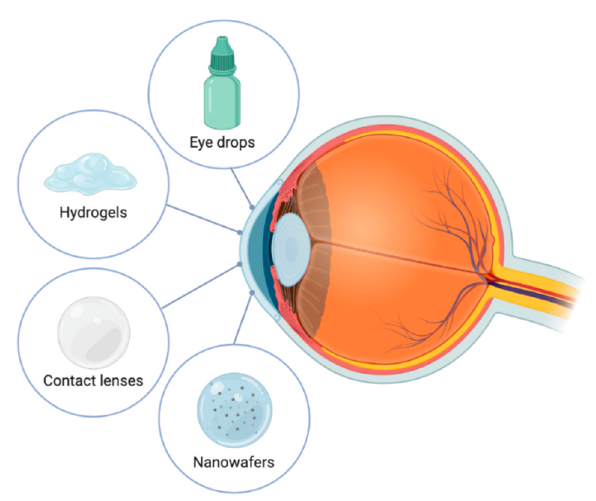
Figure 2. Drug delivery systems developed for cysteamine ophthalmic administration.